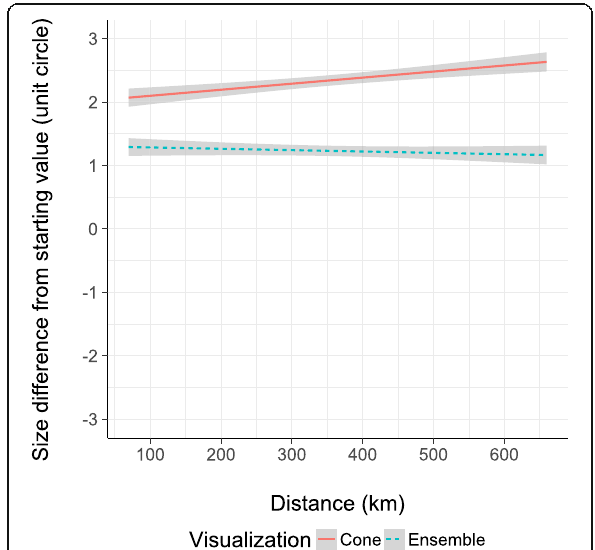
Fig. 6 The effect of distance from center and visualization type on change in size judgments. Grey shading indicates ± 1 standard error. Accurate interpretation would be indicated by a ‘ 0 ’ change score. A